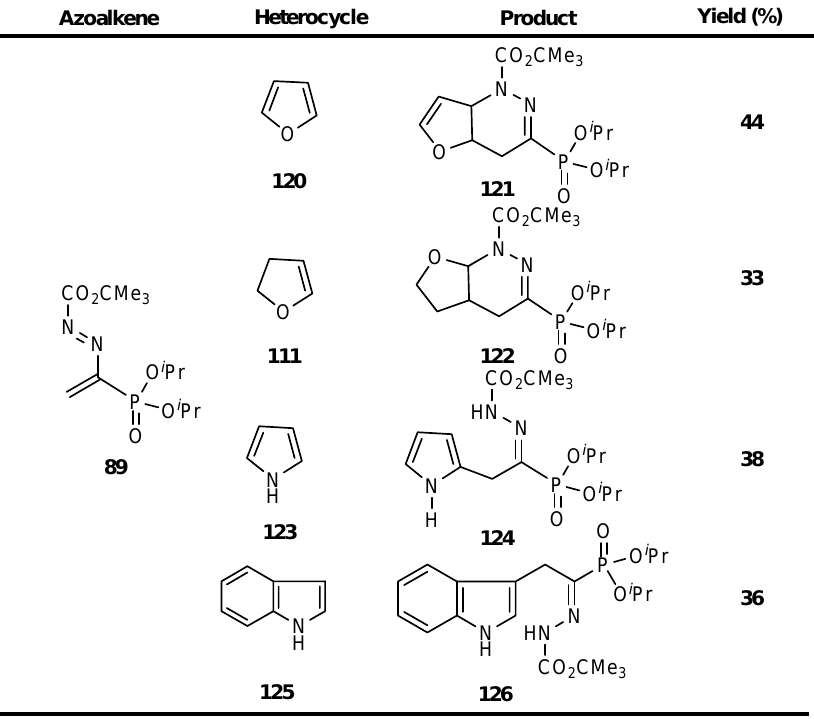
Table 2. Reactions of azoalkene 89 with electron-rich